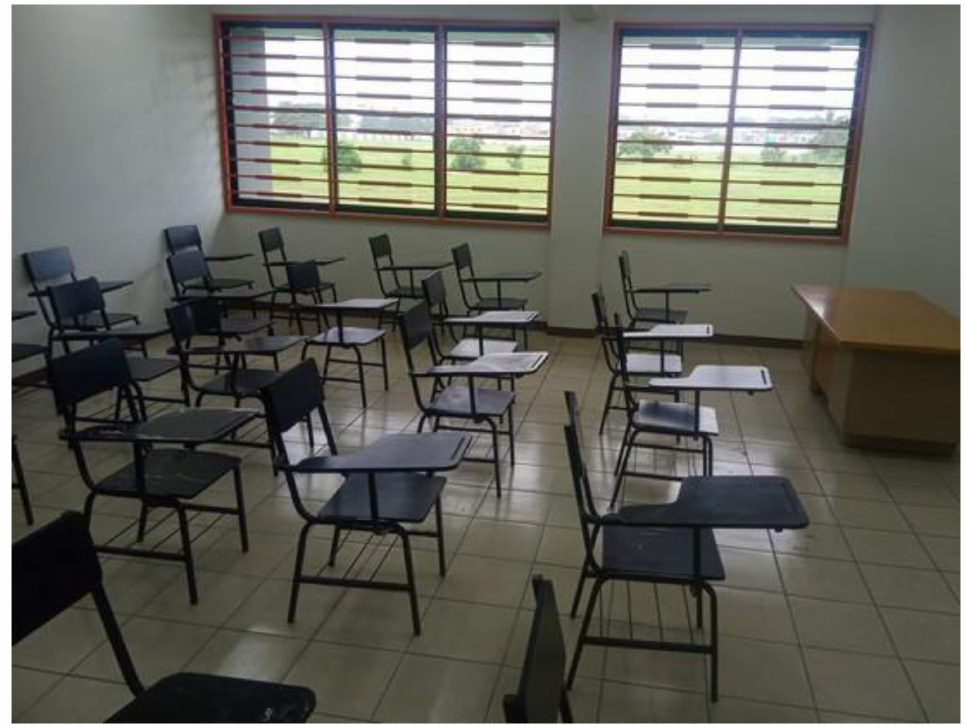
Figure 1. Classroom analyzed in building “X” of the Tecnol ó gico Nacional de M é xico, Campus Veracruz, located in the port of Veracruz,